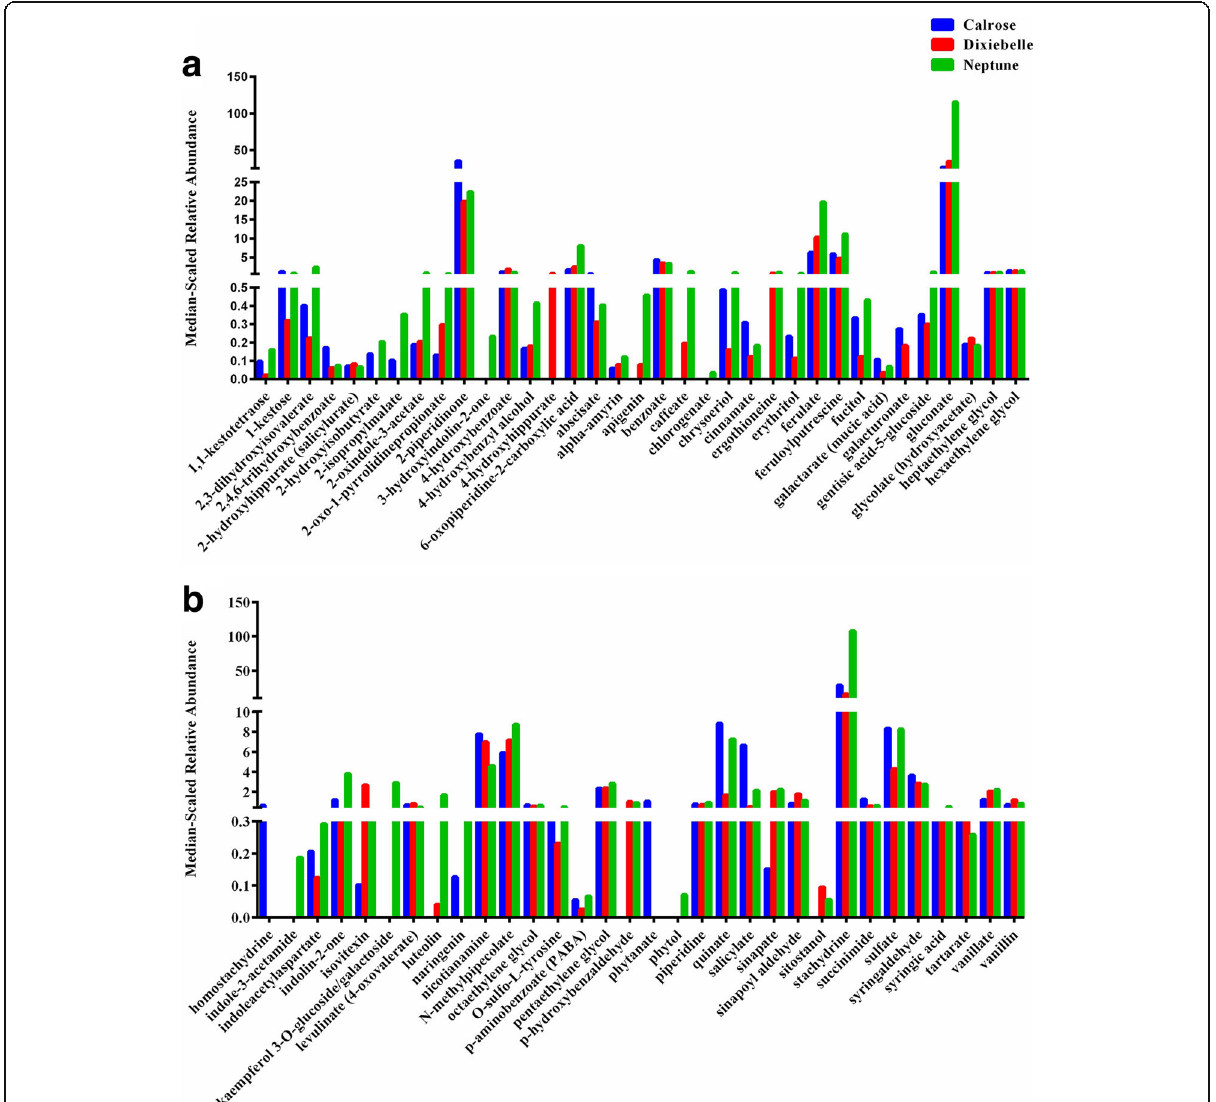
Fig. 3 Secondary metabolites detected in rice bran across 3 U.S. varieties. Rice bran metabolites were normalized by median of relative abundance for the entire dataset. a shows half of metabolites identified within secondary metabolites metabolic pathways and their difference in median-scaled relative abundance across three varieties. b shows another half of identified secondary metabolites and their difference in medin-scaled relative abundance across three